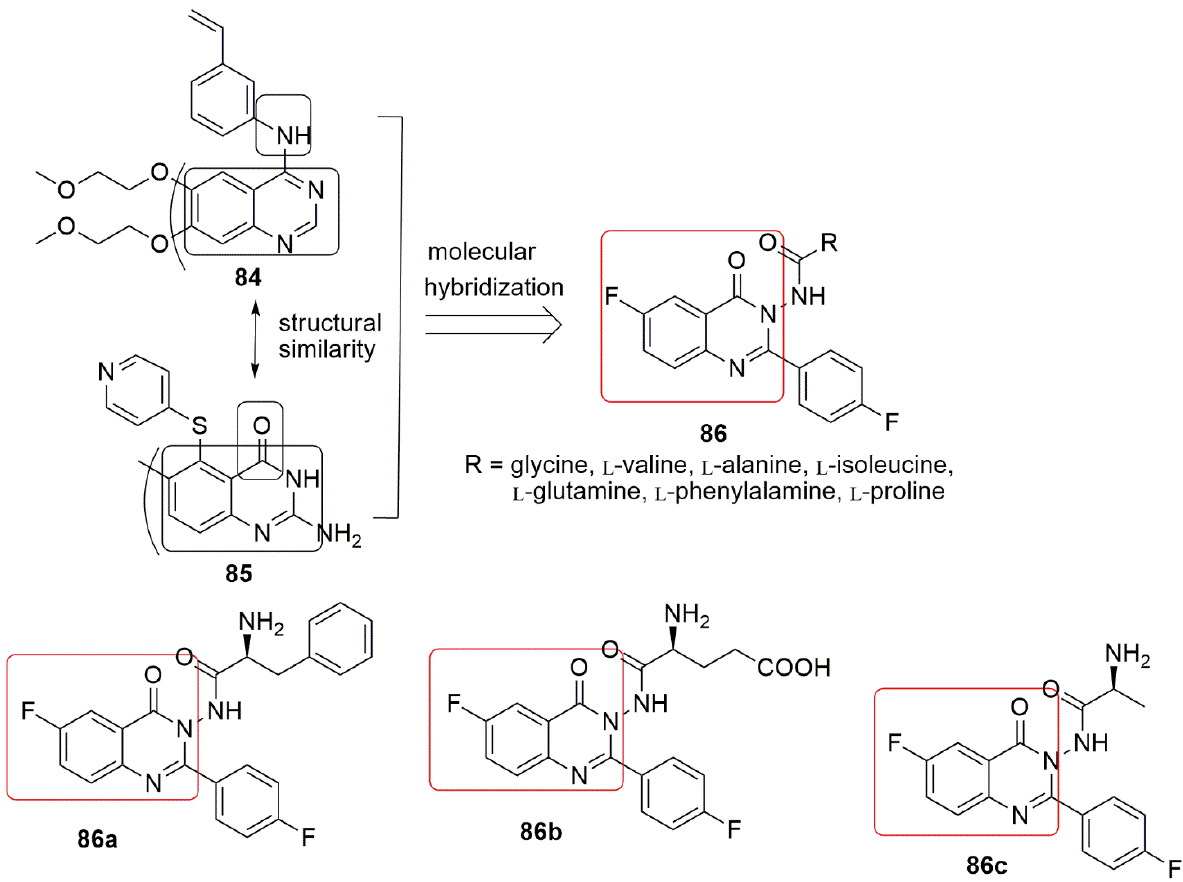
Figure 25. Chemical structures of quinazolinones derivatives evaluated for biological activity.